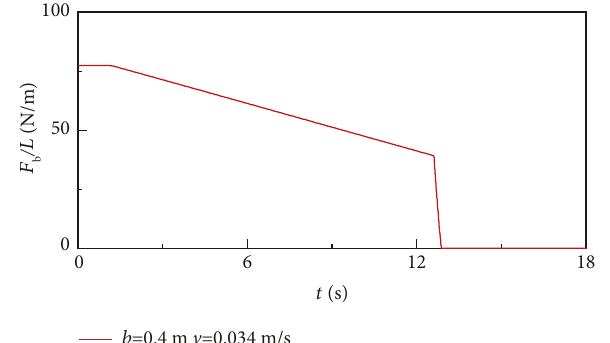
Figure 15: Virtual buoyancy evolution during the water-exit process.